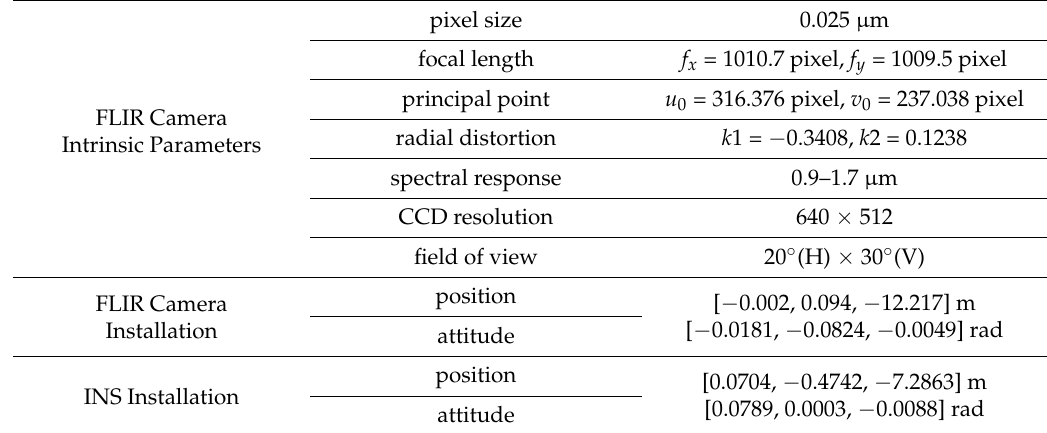
Table 1. The calibrated parameters of INS and FLIR